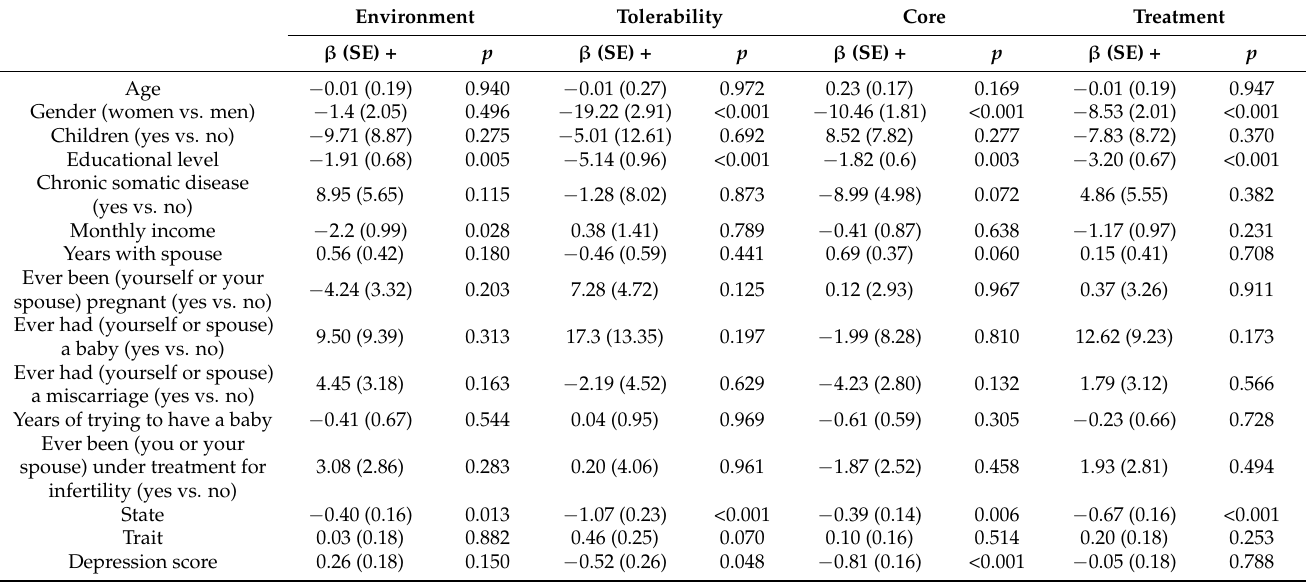
Table 4. Multiple linear regression results for “Environment”, “Tolerability”, “Core”, and “Treat- ment”